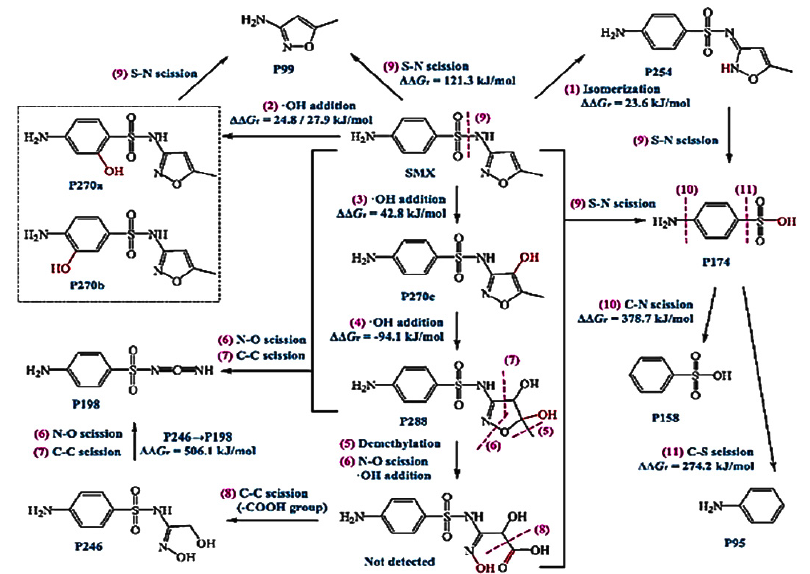
Figure 4. Mechanism of photolytic oxidation/reduction of SMX and the formation of various transformative products (TPs) during its photolysis (reproduced from [28] Copyright Year 2019, Chemical Engineering Journal @Elsevier with permission License number: 5114291052991©